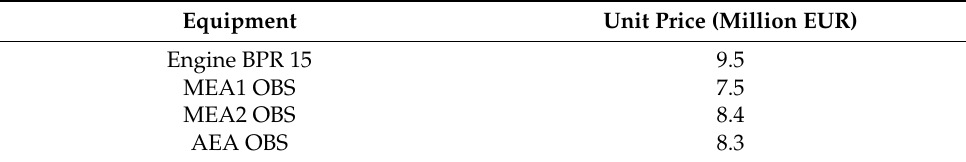
Table 10. List of the equipment considered for engine replacements and OBS electrification retrofitting. The unit price of every single item is indicated.